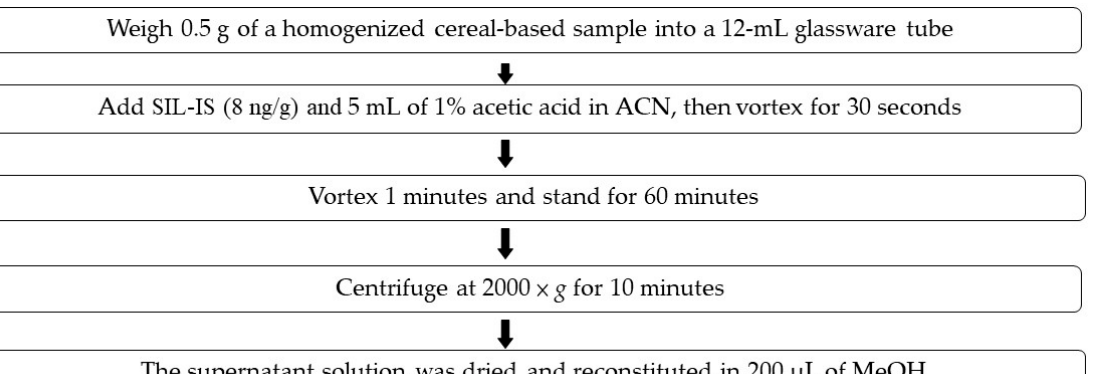
Figure 2. A flowchart of sample pretreatment, solid–liquid extraction.